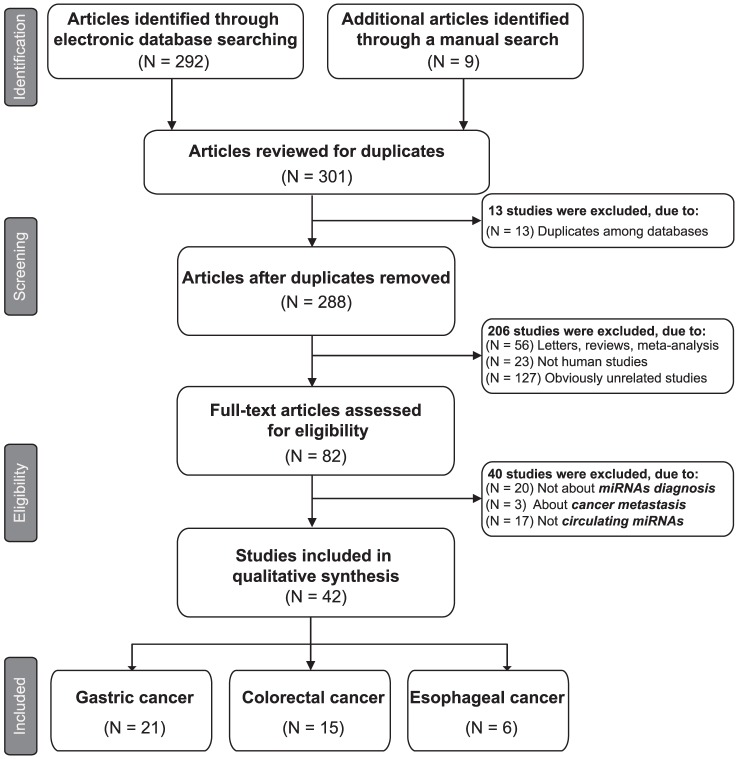
Flow diagram of study selection process.